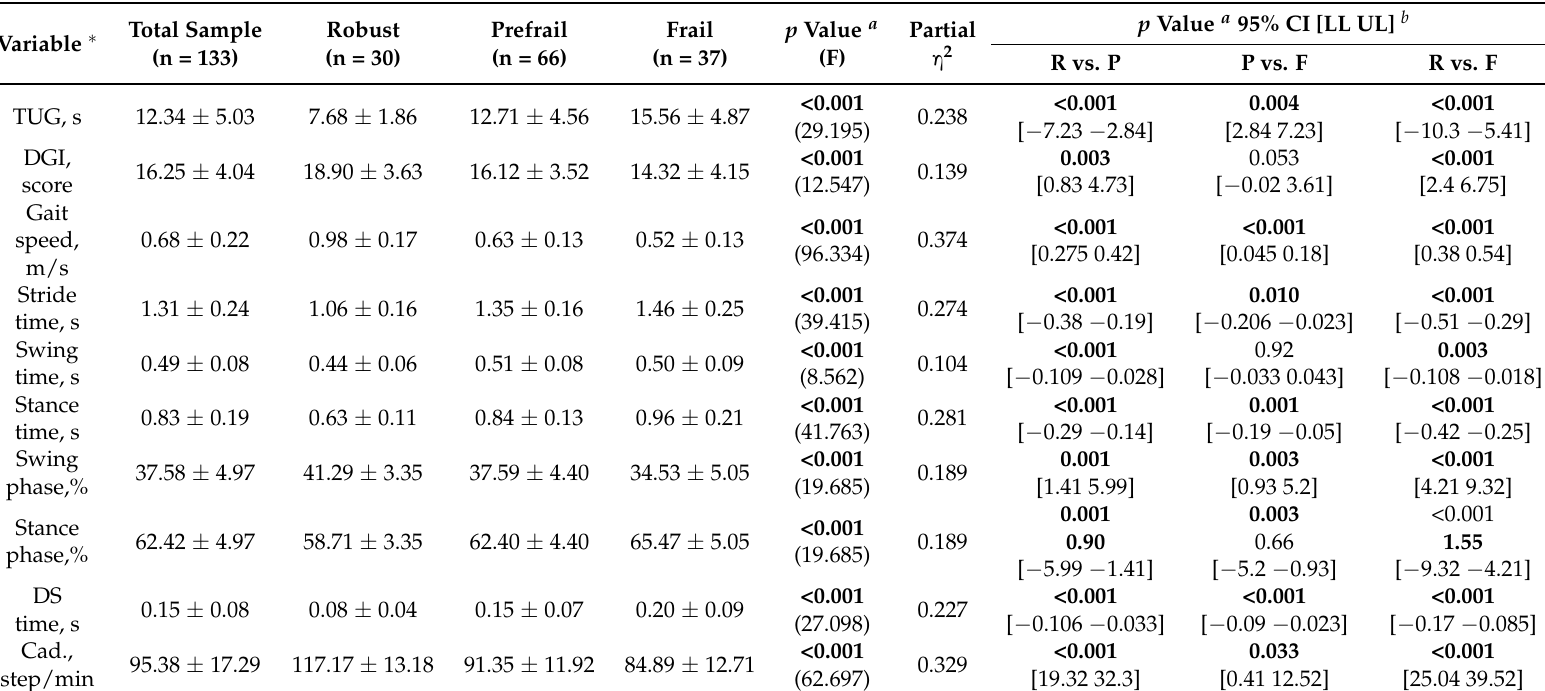
Table 3. Results of the gait assessment stratified by frailty